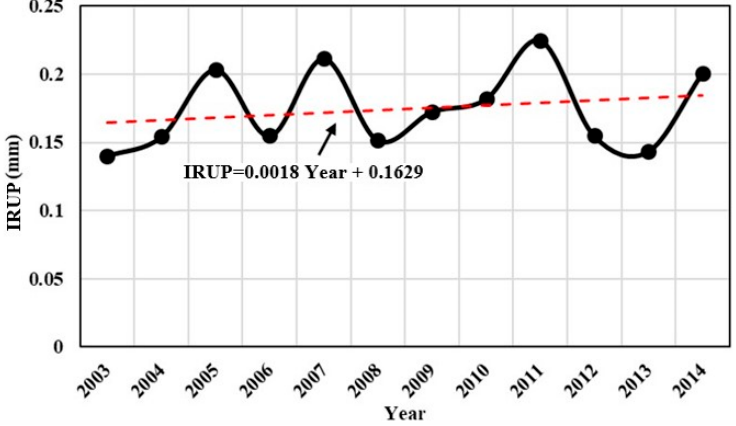
Figure 6. The changing trend of the average rainwater utilization potential index (IRUP) in the Loess Plateau.